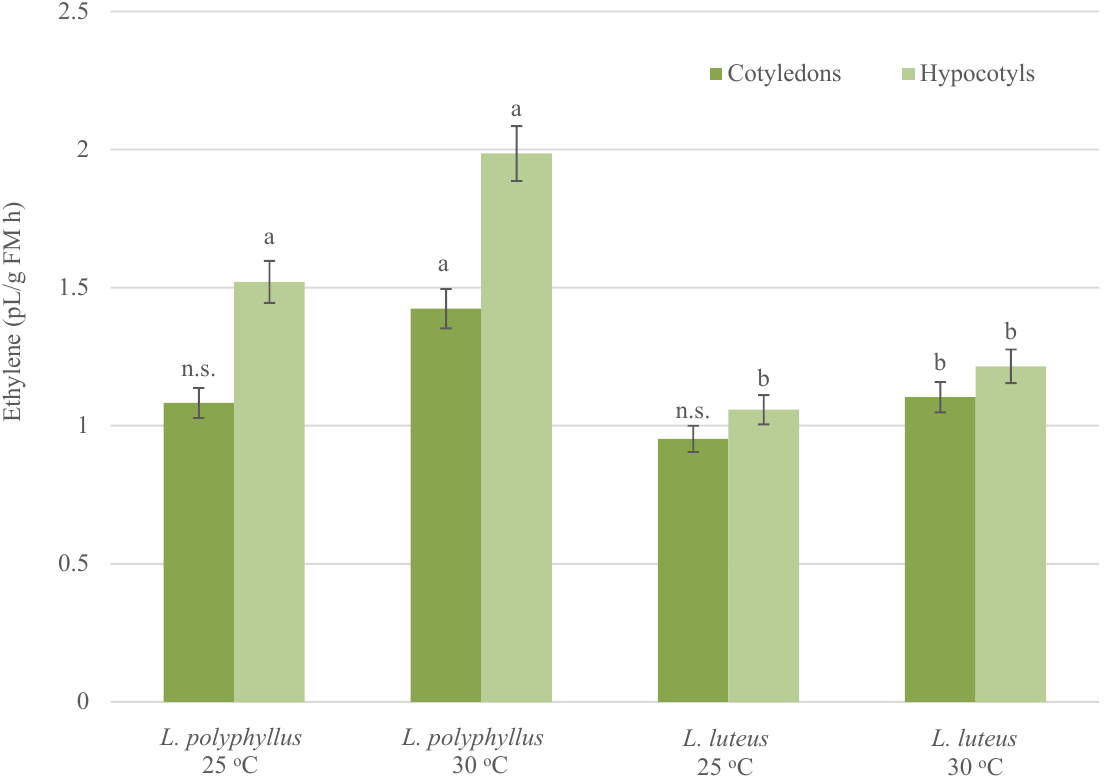
Figure 4. Ethylene production in seedlings grown at 25 °C and 30 °C. Values are mean ± SD of three experiments with five replicates in each. Different letters indicate significant difference ( p < 0.05) between two lupine species grown under the same temperature; n.s.—non-significant difference.